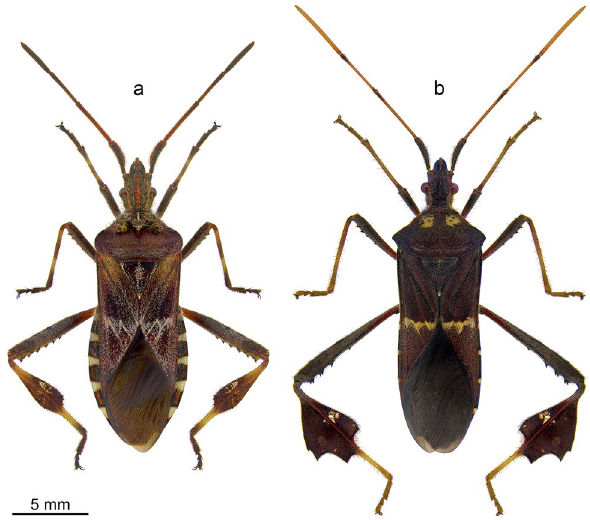
Figure 1. Dorsal habitus of examined species: L. occidentalis ( a ) and L. zonatus ( b